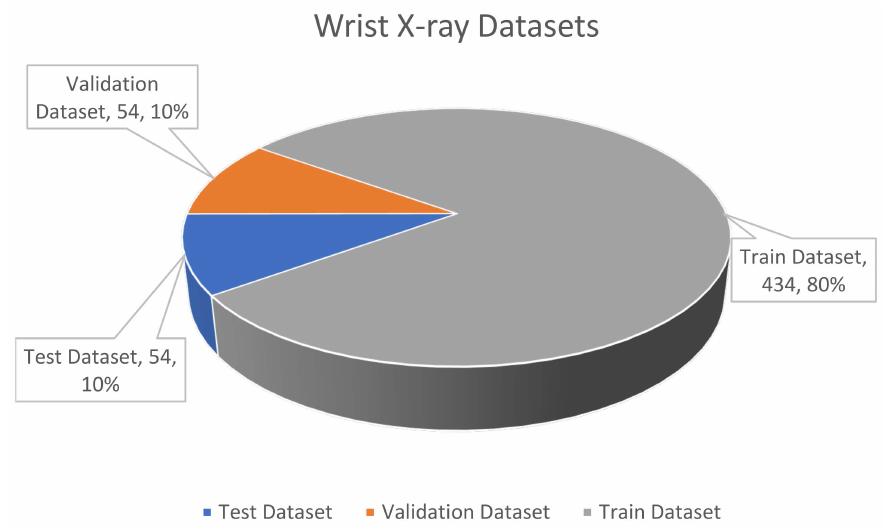
Figure 10. The wrist X-ray dataset. Table 3. Details of wrist fracture